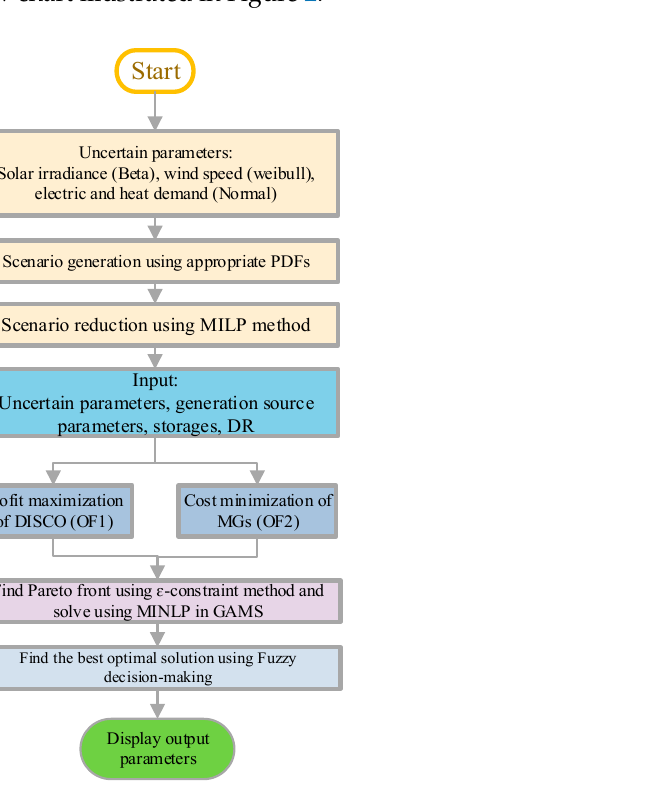
Figure 2. Solution steps for stochastic multi-objective